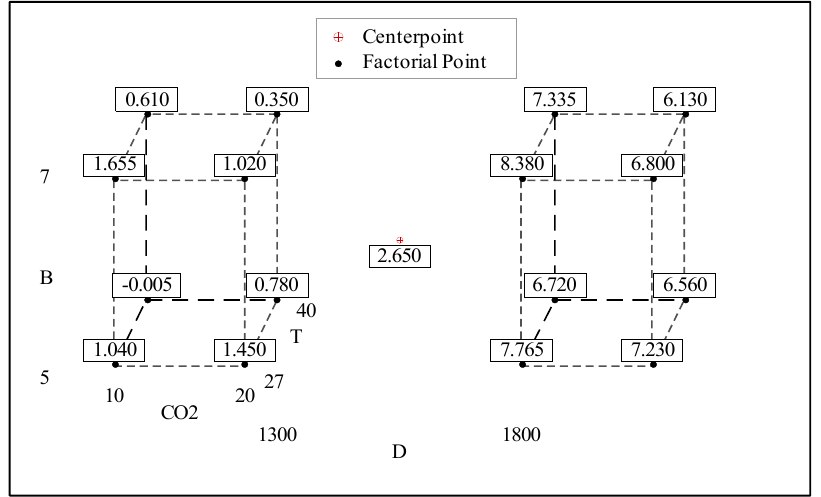
Figure 3. Cube plot of compressive strength.